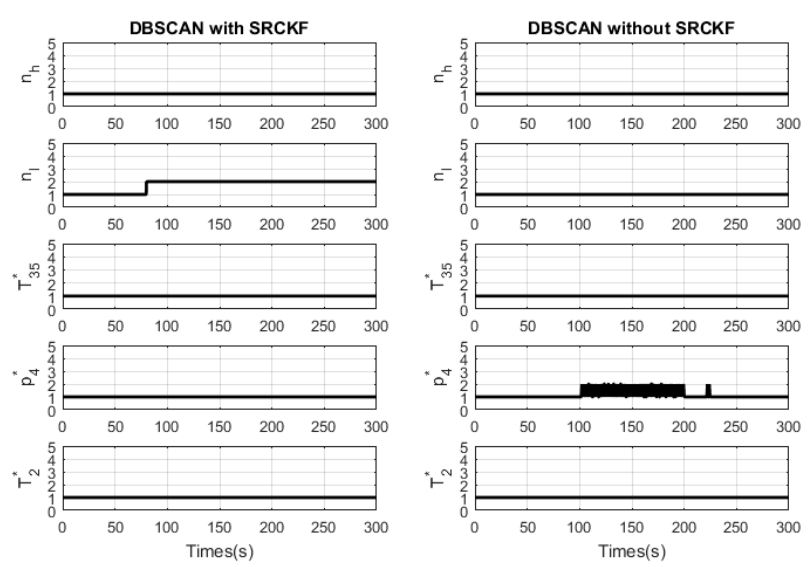
Figure 9. The contrast experiment between our proposed DBSCAN and the general DBSCAN.